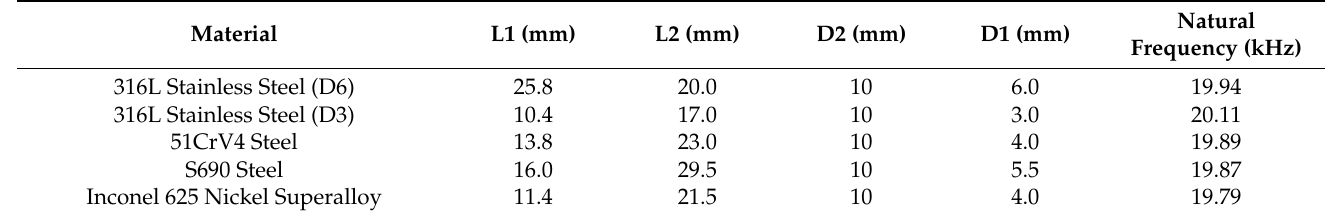
Table 2. UHCF specimens’ main dimensions and experimental natural